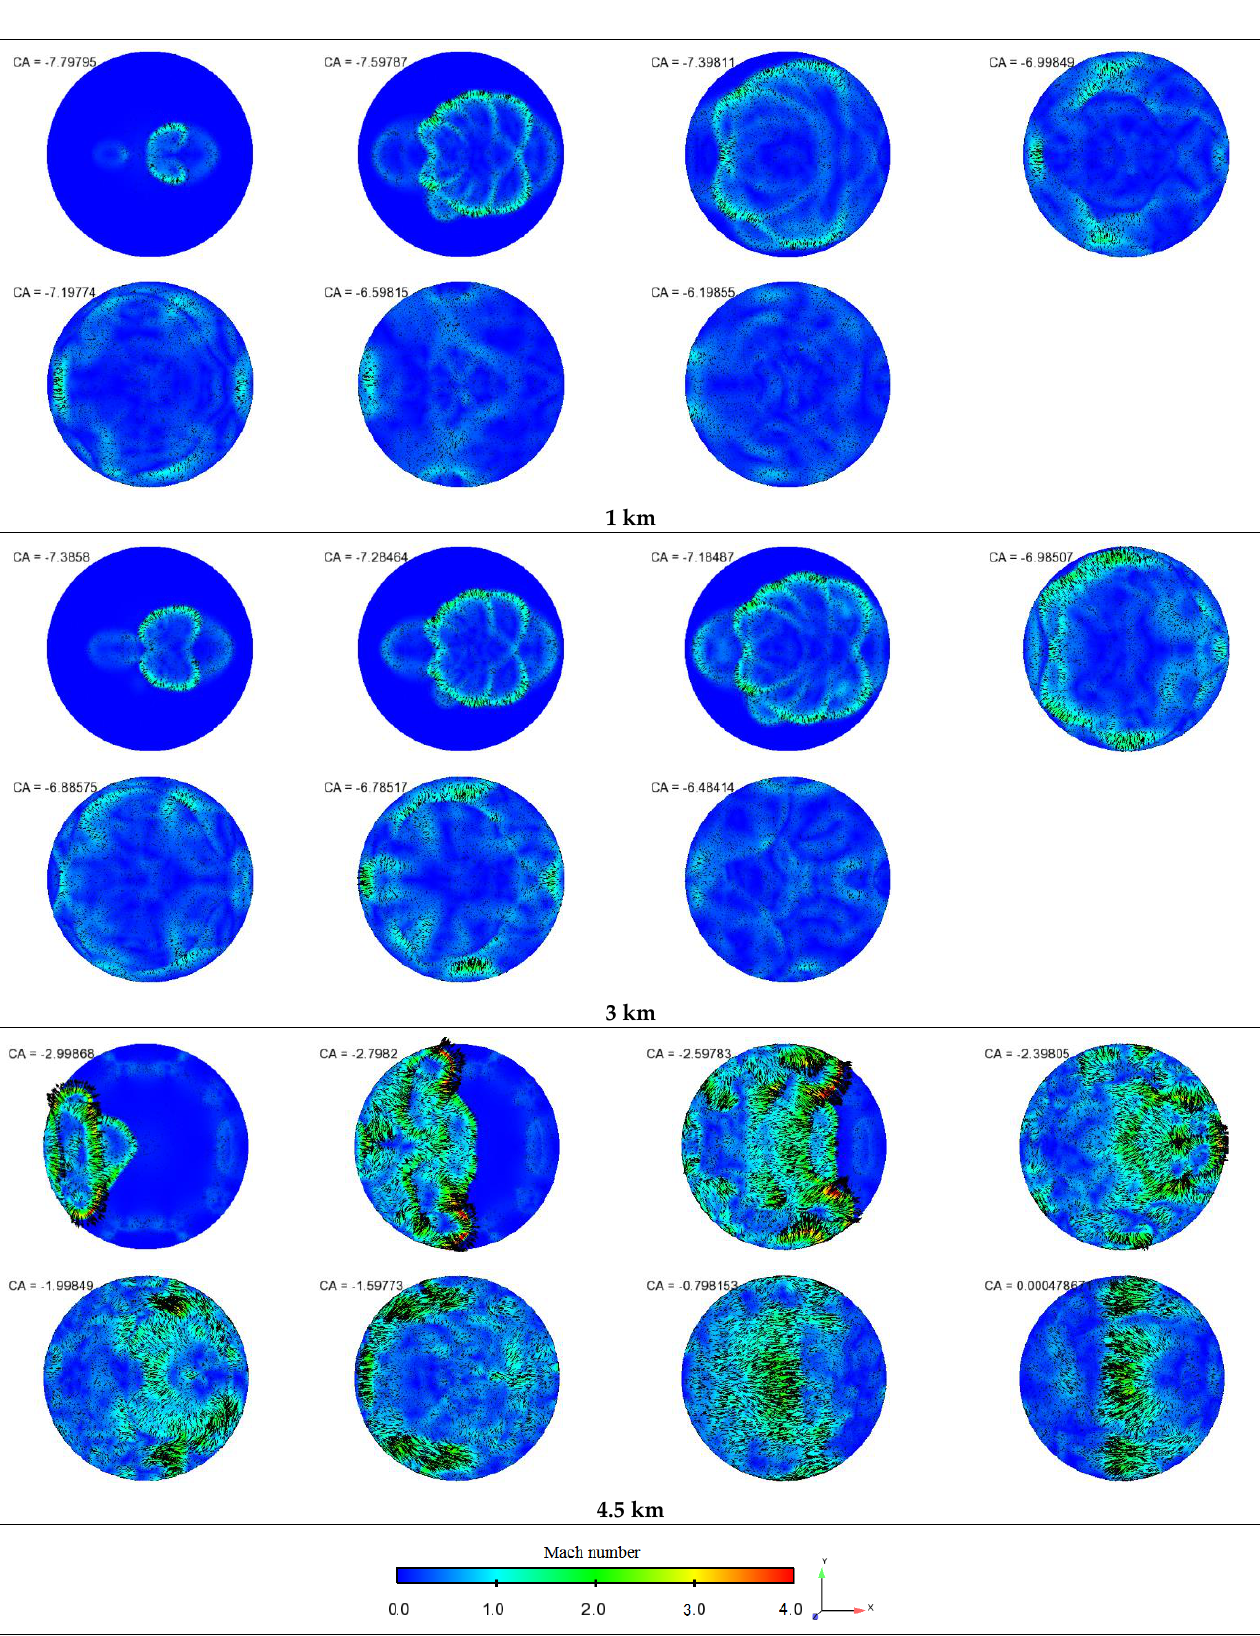
Figure 12. Comparison of pressure distribution at various altitudes.